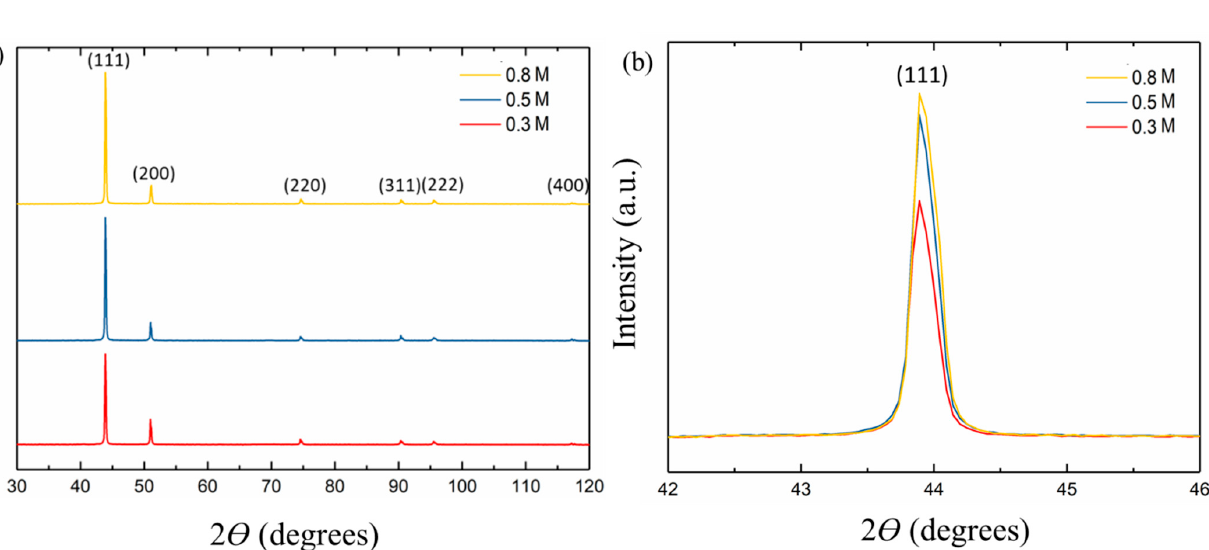
Figure 9. Plan-view EBSD (111) orientation maps (OIMs) of the 15- μ m thick nt-Cu foils electroplated with different con- centrations of Cu 2+ : ( a ) 0.3 M; ( b ) 0.5 M; ( c ) 0.8 M.